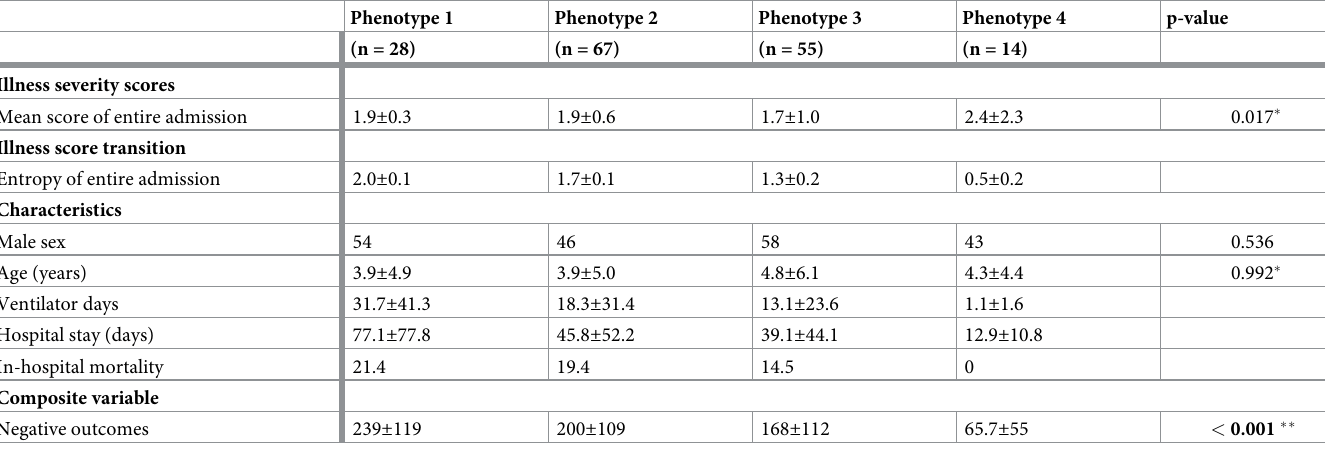
Table 3. Characteristics of dynamic phenotypes: Four